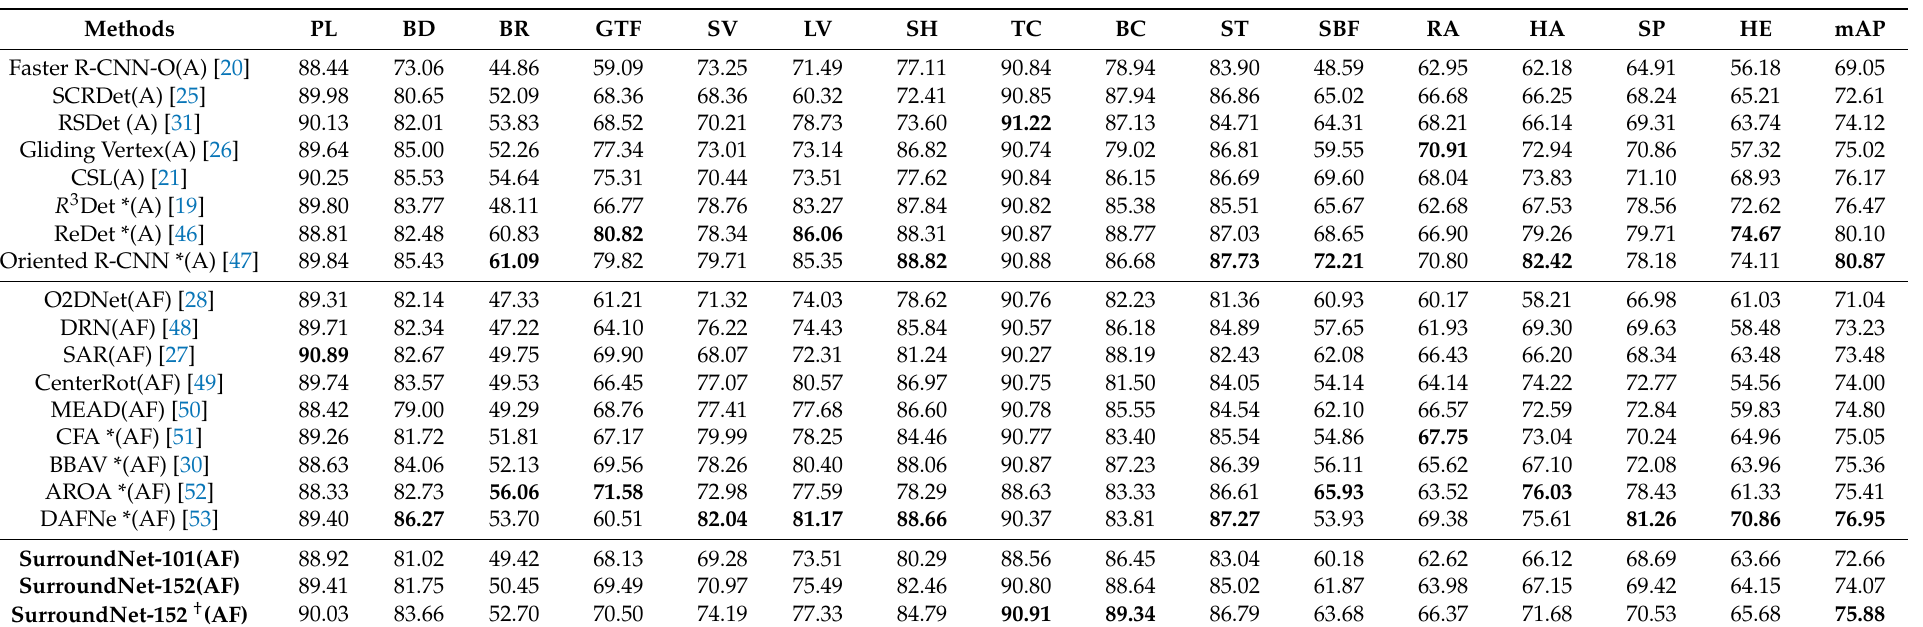
Table 6. Evaluation results of detection on the DOTA test dataset. ’*’ means using multi-scale training and multi-scale testing. ‘†’ means that only multi-scale testing was